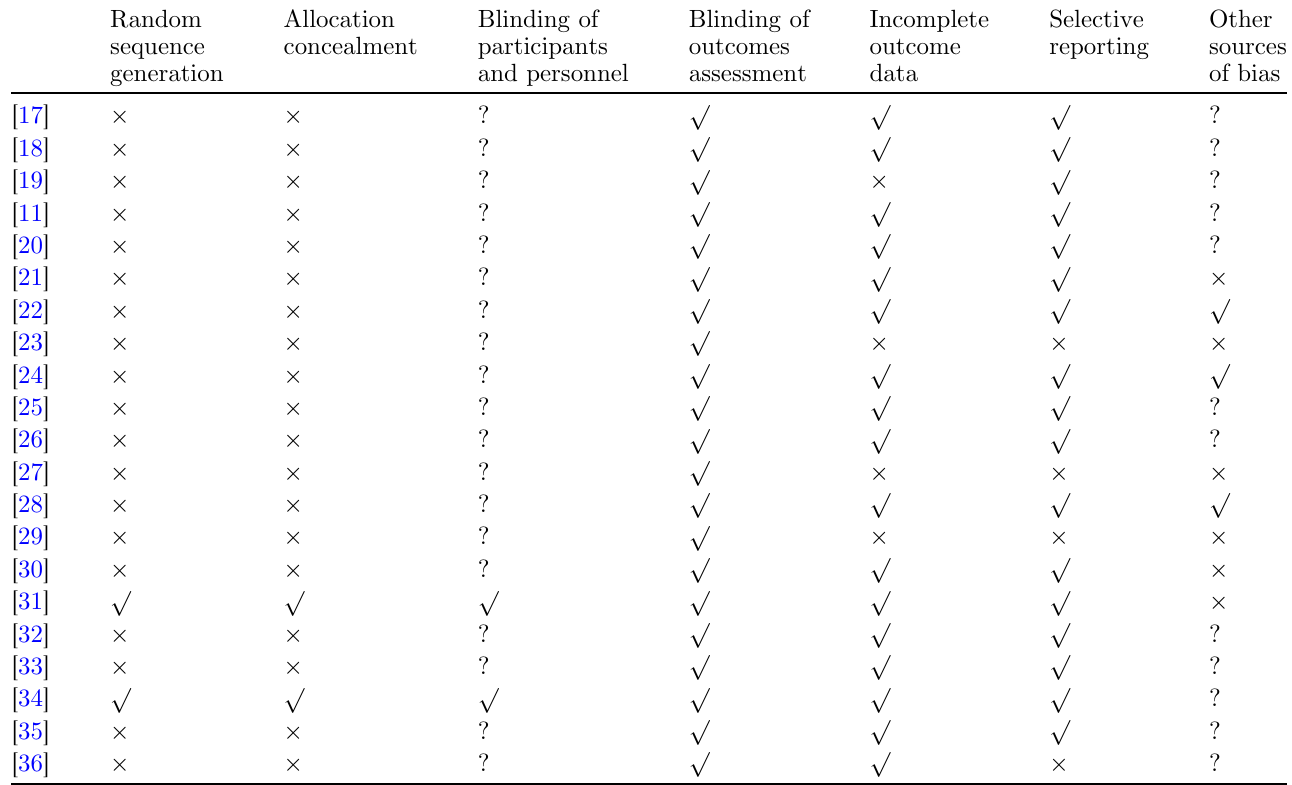
Table 2. Risk of bias assessment summary of the seleceted studies. Random sequence